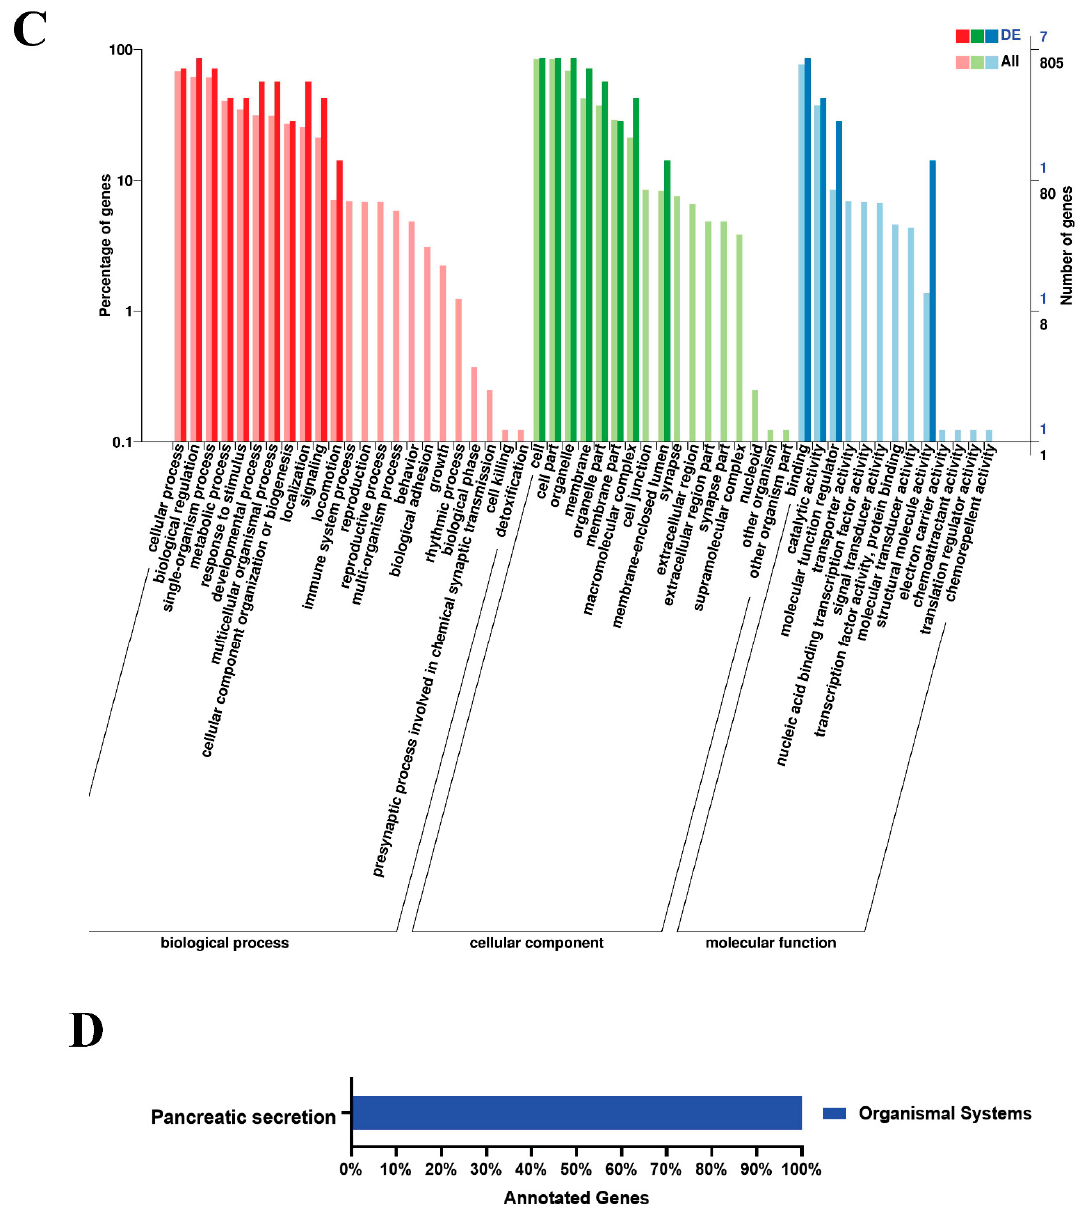
Figure 3. Enrichment analysis of the differentially expressed circRNAs. ( A ) Differential expression analysis of four groups of circRNAs. ( B ) CircRNA expression volcano plot. ( C ) GO analysis of the differentially expressed circRNAs. ( D ) KEGG pathway enrichment analysis of the differentially expressed circRNAs.